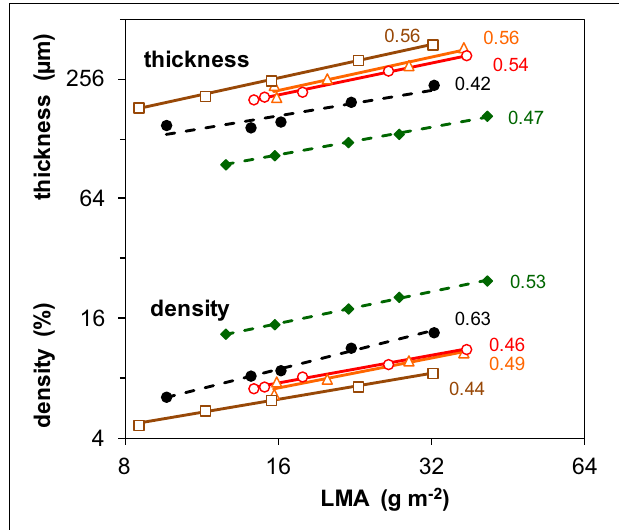
FIGURE 2 | Changes in leaf tissue density and thickness associated with the changes in leaf dry mass per area (LMA) as induced by different irradiance levels. Data are given for five species and are average values pertaining to all leaves of the plant. The regression coefficients from a scaling slope analysis, quantifying the fractional contribution of leaf density and thickness to variation in LMA given to the right of the lines. LMA is the inverse of SLA shown in Figure 1C . Mean values ( n = 8) of density and thickness were log-transformed and plotted against log-transformed LMA. For symbols see Figure 1 . The values of LMA, tissue density and leaf thickness are given in Supplement Table S1. For further explanation of the scaling slope analysis see text.